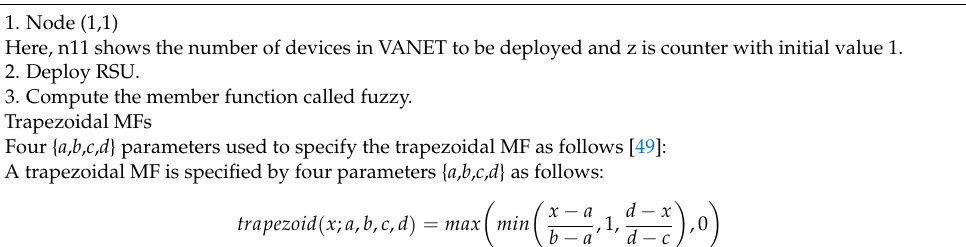
Algorithm 2. Deploy vehicular ad hoc network (VANET) nodes